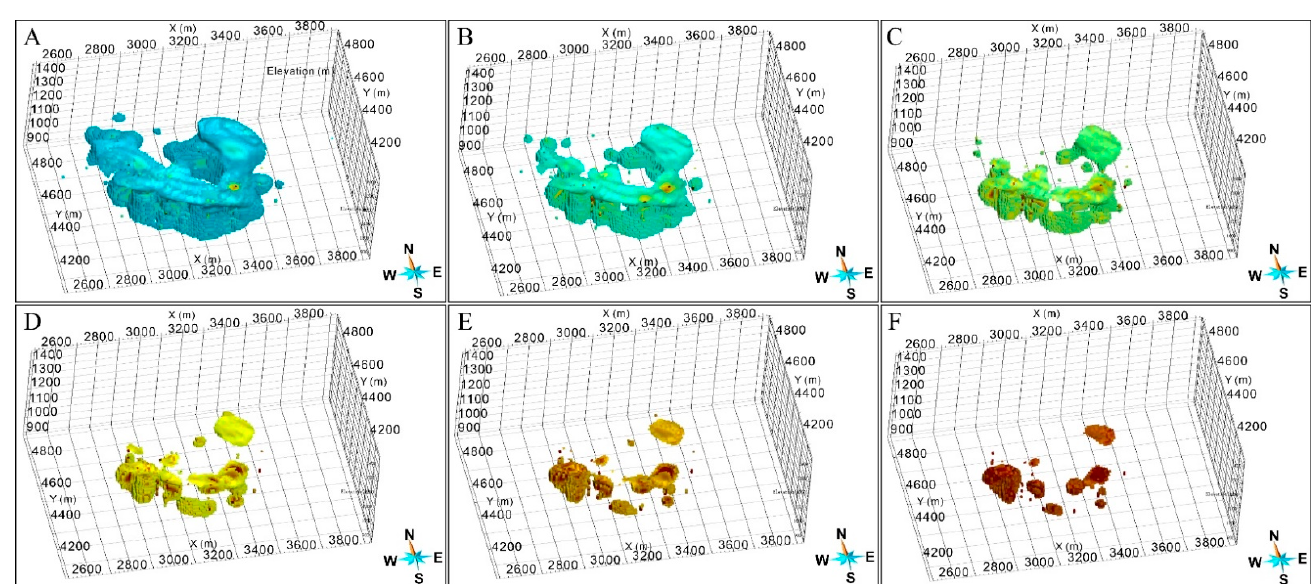
Figure 9. Distribution of Mo orebodies with different grades: ( A ) the grade > 0.10%; ( B ) the grade > 0.15%; ( C ) the grade > 0.20%; ( D ) the grade > 0.25%; ( E ) the grade > 0.30%; ( F ) the grade > 0.35%.